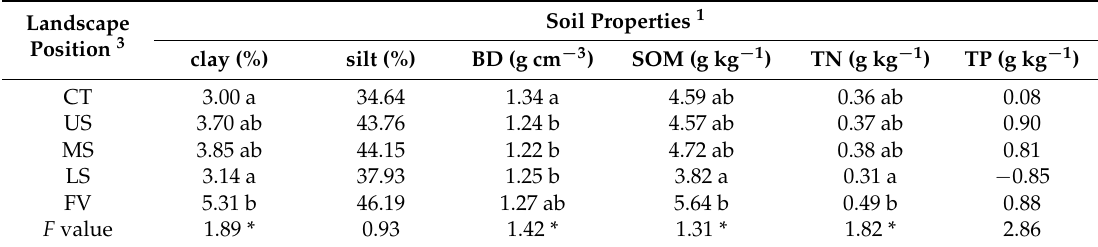
Table 4. Comparison of soil properties at different landscape